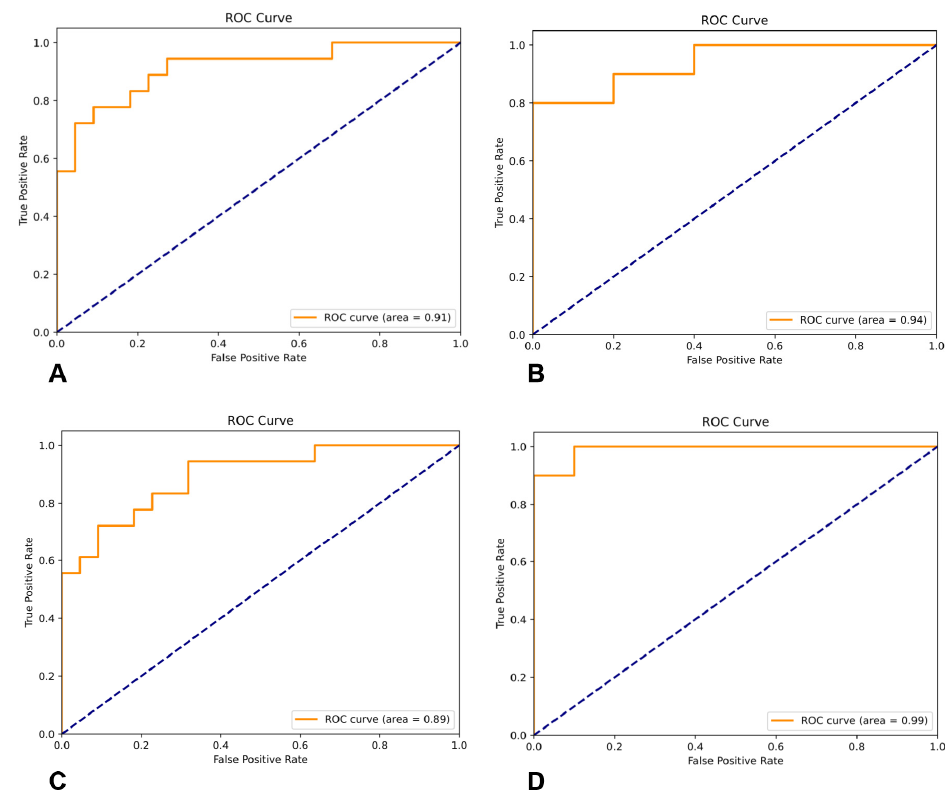
Figure 2. Receiver operating characteristic (ROC) curve of different models. ( A ) LR model variables. ( B ) RF model variables. ( C ) SVM model variables. ( D ) CNN model